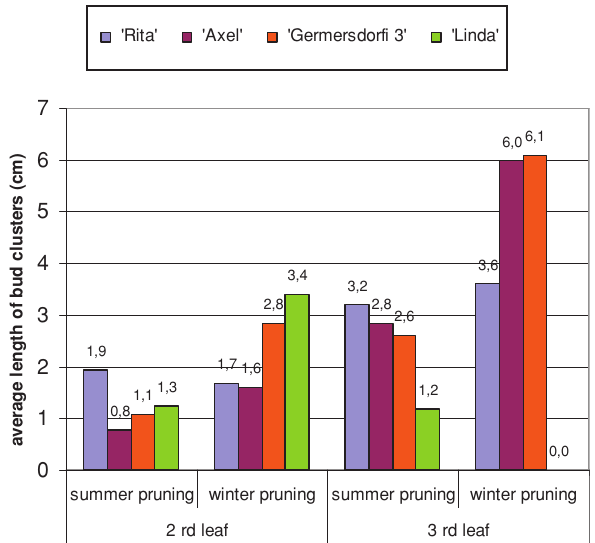
Figure 3. Daily minimum and maximum temperatures at Pallag between 2009, October 1 and 2010, February 28 (Debrecen–Pallag, 2010)